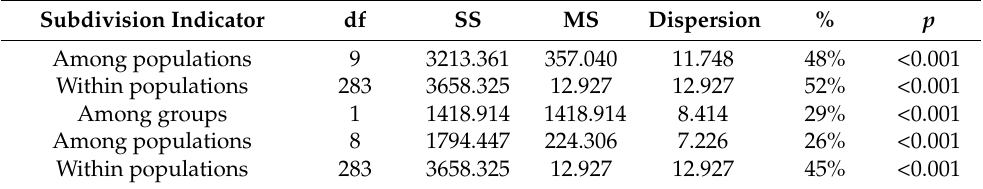
Table 3. Assessment of genetic intra- and interpopulation variability of P. sylvestris populations based on the analysis of molecular variability (AMOVA).